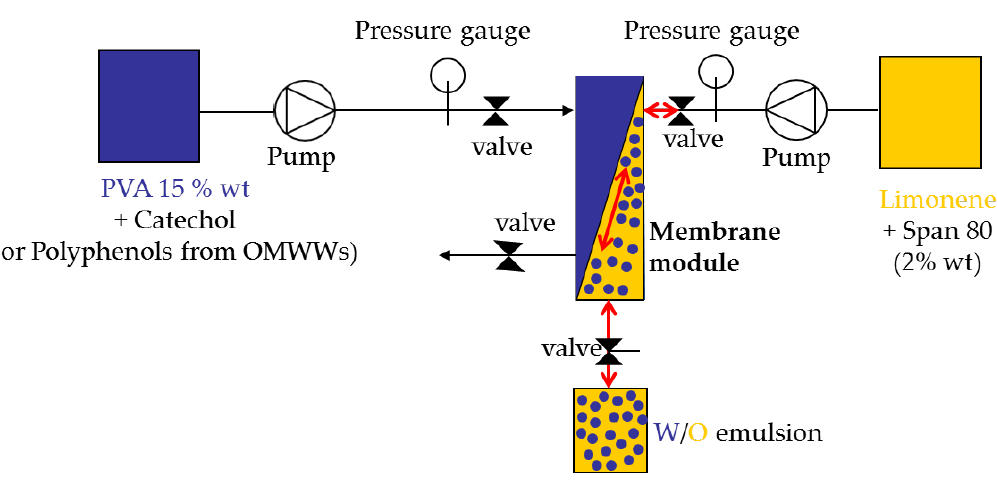
Figure 6. Membrane emulsification plant.